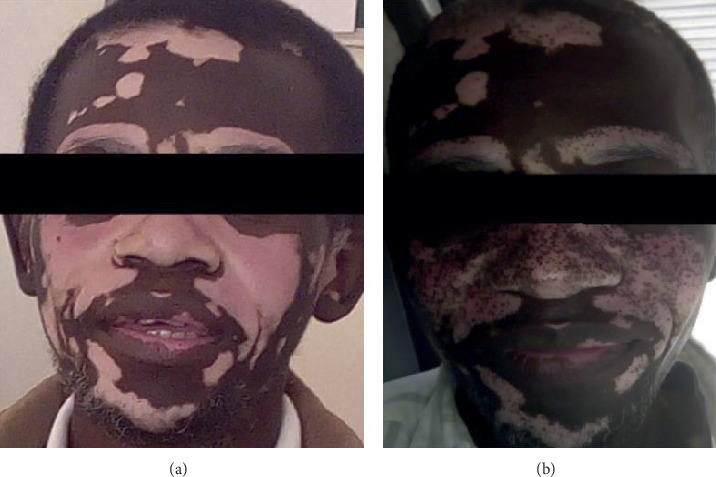
(a) Before treatment with parenteral vitamin B12. Hypopigmented, well-demarcated patches on the nose, lips, cheeks, eyebrows, part of the ears, and forehead in a symmetrical distribution. (b) Repigmentation of affected parts of the skin 3 weeks after treatment.